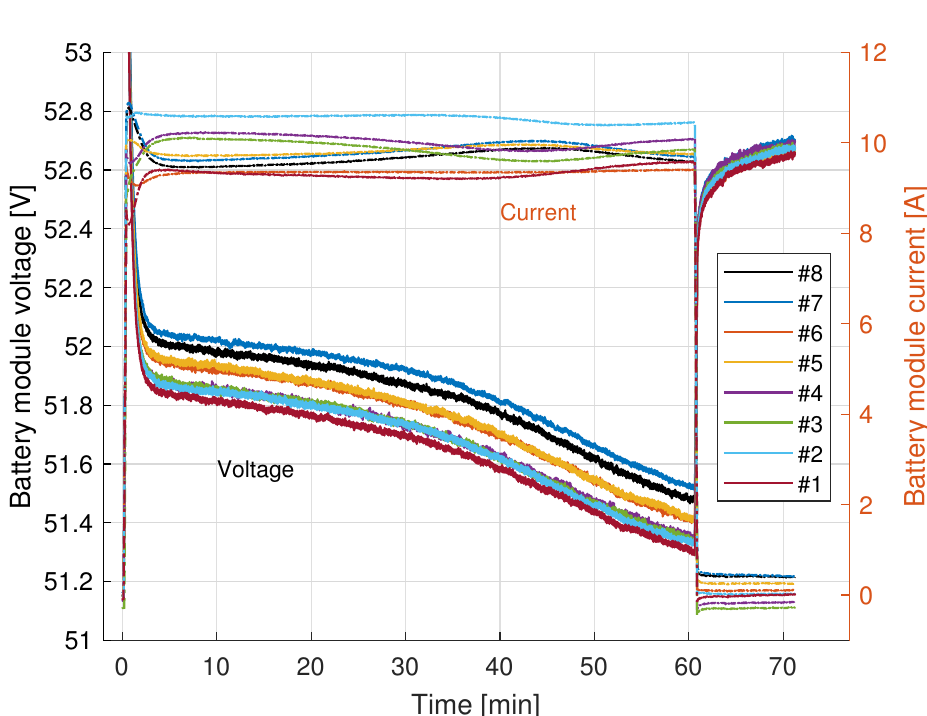
Figure 8. Discharging of batteries in parallel configuration during 1 h at 80A, corresponding to highway cruising at